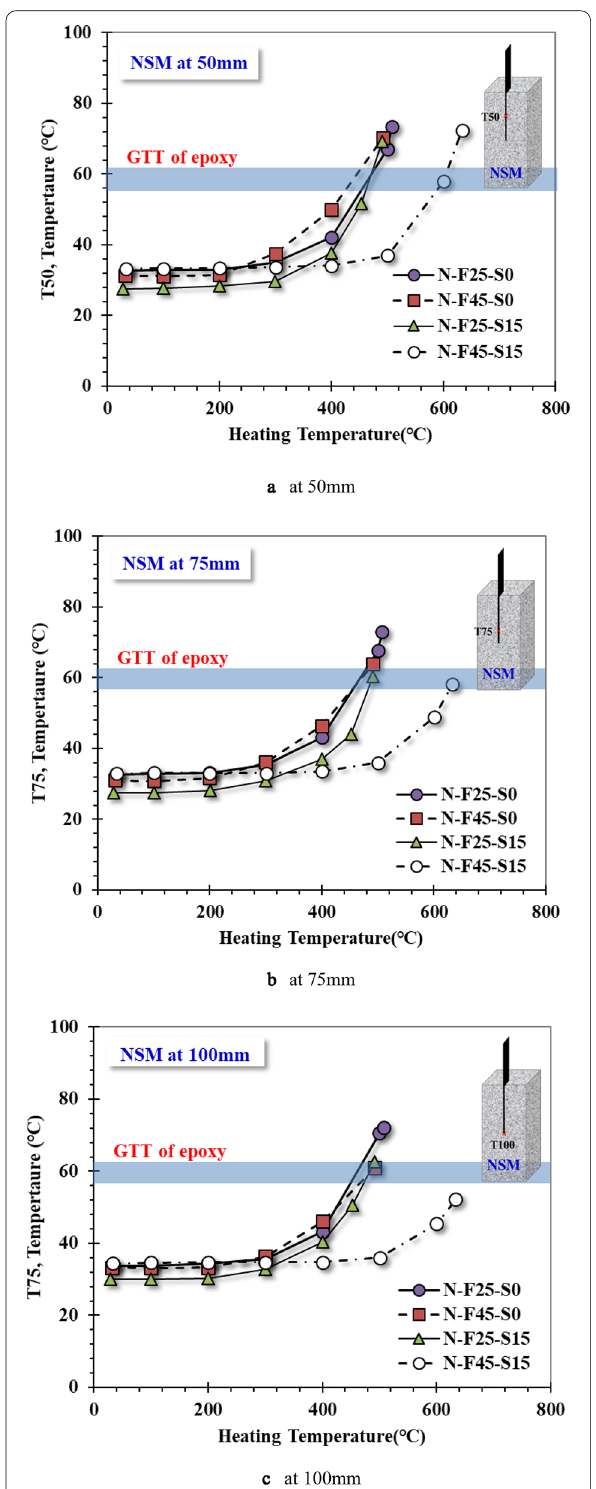
Fig. 19 Temperature increase of epoxy at each location in NSMR specimens corresponding to heating